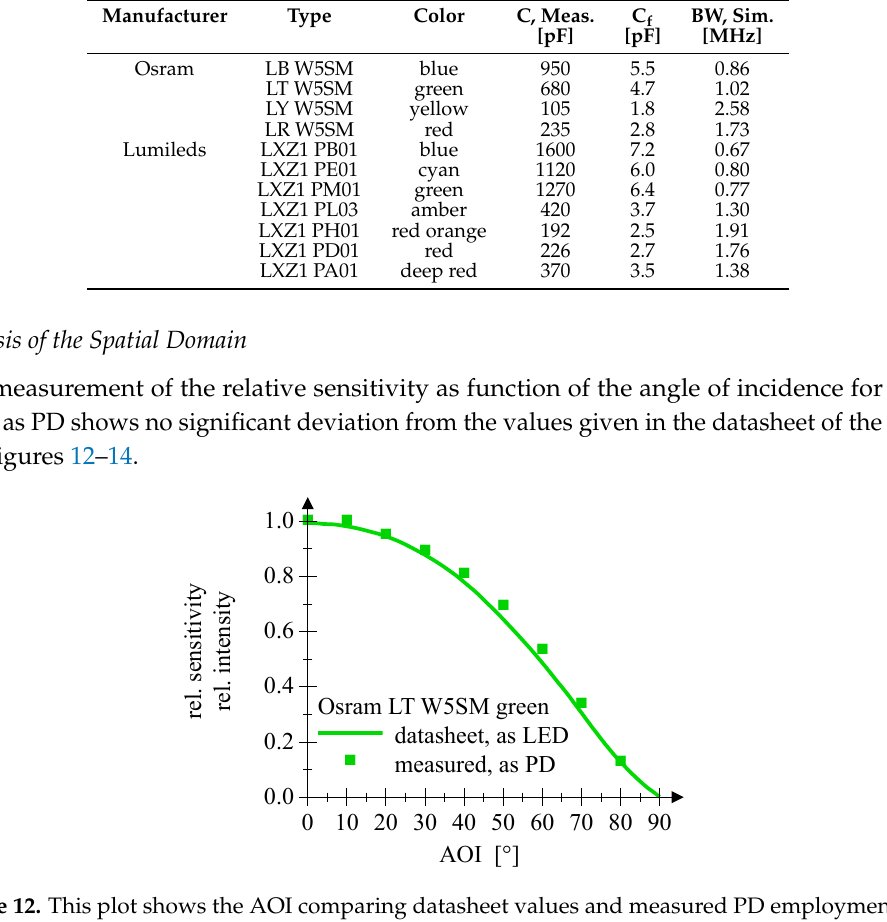
Figure 12. This plot shows the AOI comparing datasheet values and measured PD employment of a green Osram LED.